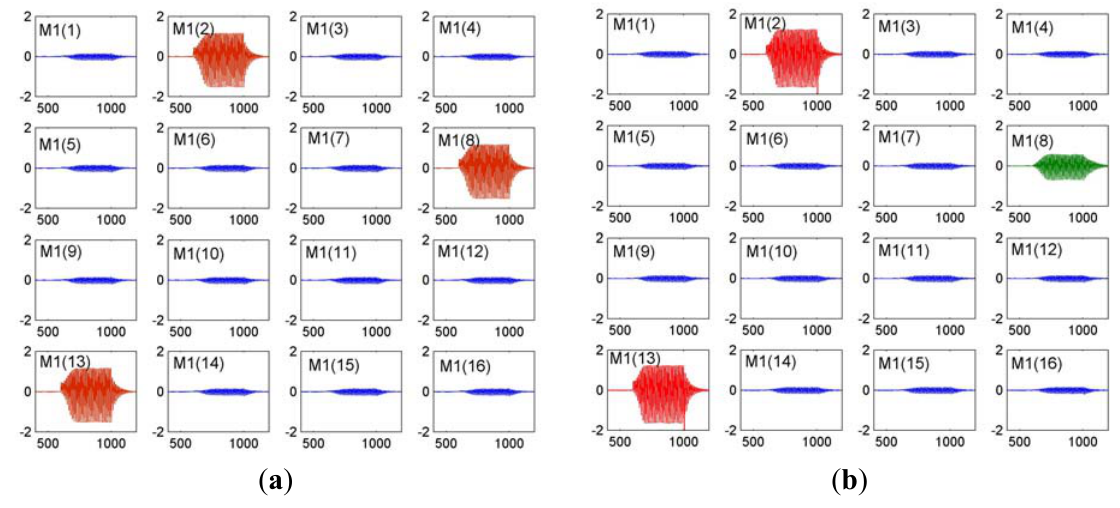
Figure 3. Binary experiments for ( a ) Pattern reproduce; ( b ) Pattern retrieval in a 16-channle KIII model with simple Hebbian learning